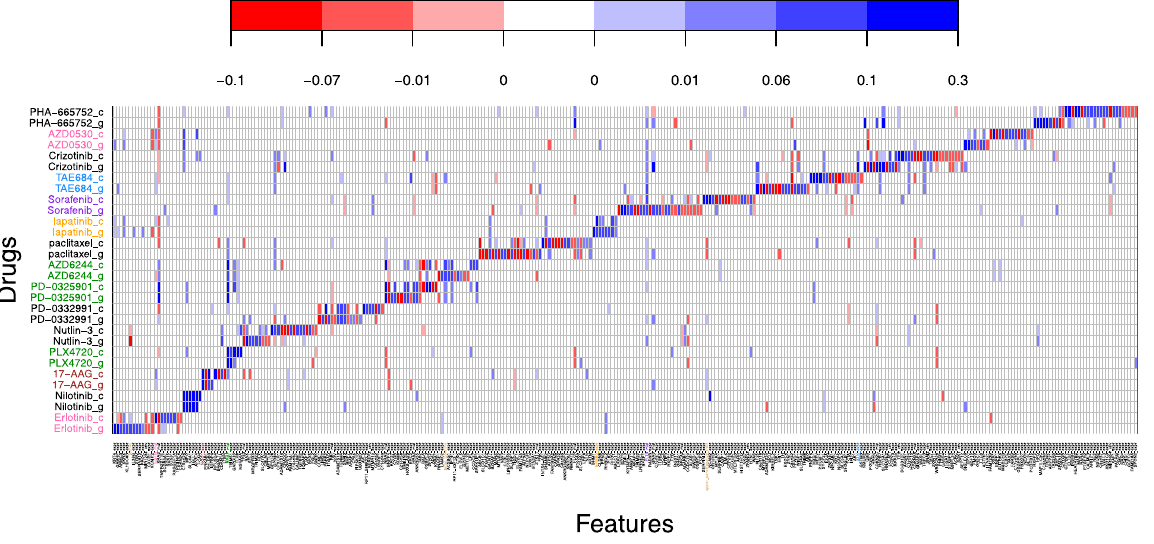
Figure 10. Signature validation plot based on GDSC (g) and CCLE (c) datasets using Formulation 2. The y-axis shows the different drugs under study. The x-axis shows the markers which had significant effects. Blue coloring indicates a positive estimated effect; red a negative estimated effect. White indicates an estimated null